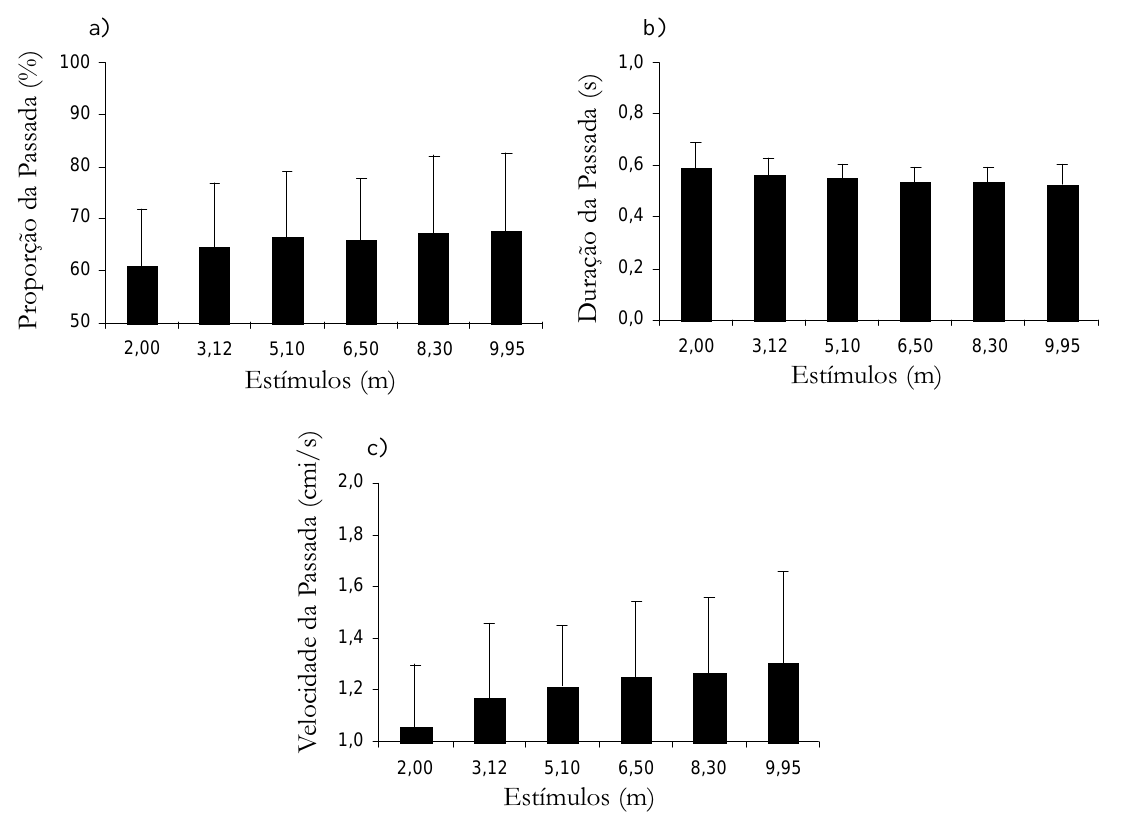
Figura 2. MØdia e desvio-padrªo dos valores da propor(cid:231)ªo da passada (a), dura(cid:231)ªo da passada (b) e velocidade da passada (c). Os valores da propor(cid:231)ªo da passada estªo expressos como uma porcentagem do comprimento do membro inferior (cmi), enquanto a dura(cid:231)ªo da passada estÆ expressa em segundos